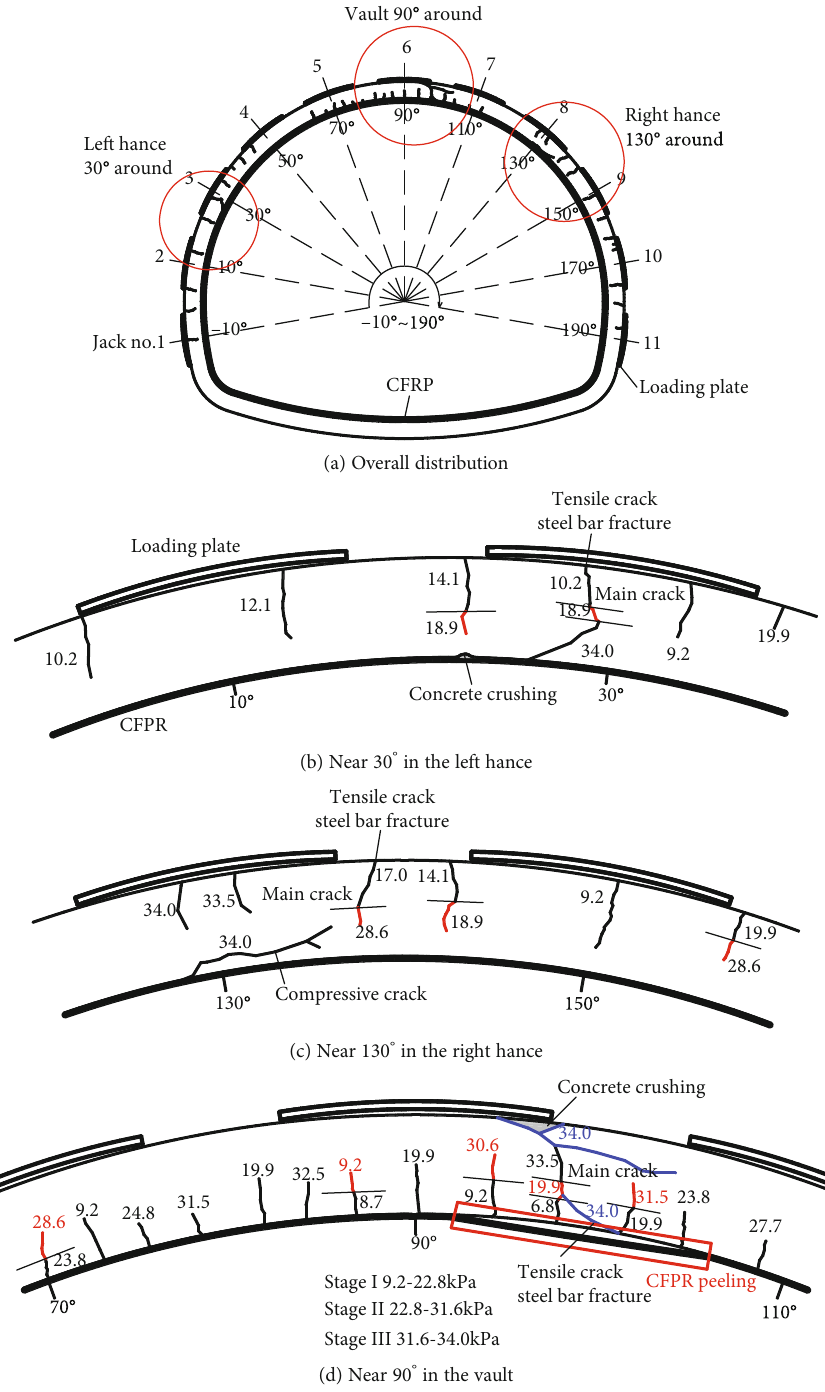
Figure 9: Fracture distribution of the lining under condition